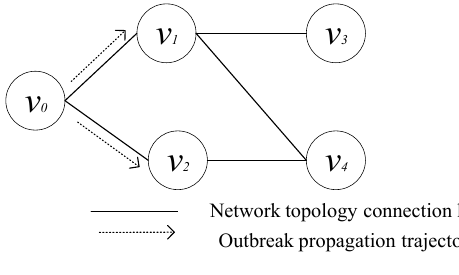
Figure 1. Propagation Trajectory